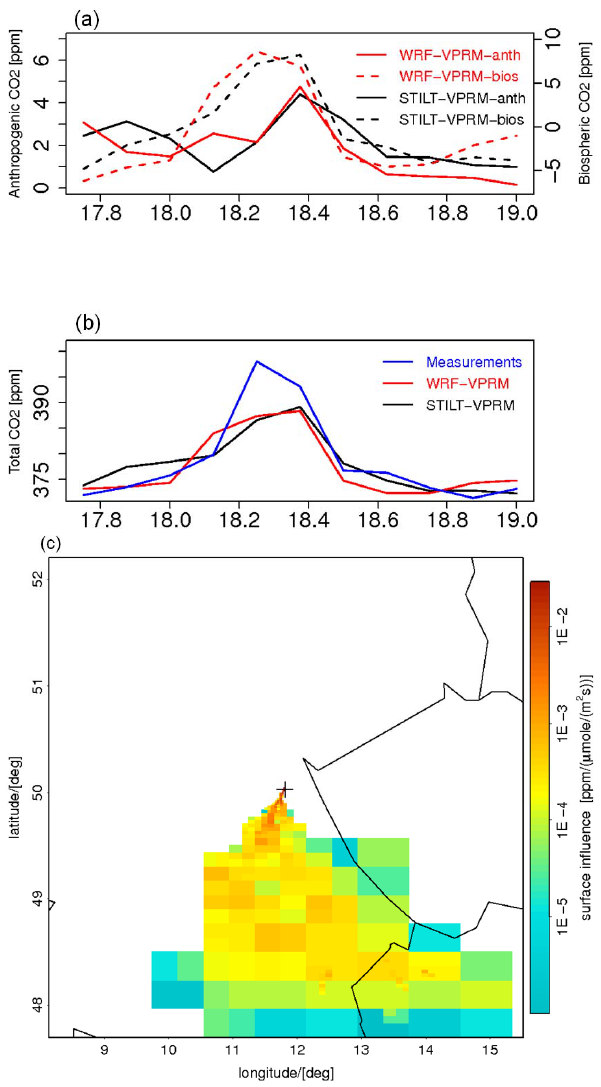
Figure 8. Influence of surface fluxes on measured CO 2 concentration at OXK: a and b) Fig. 8. Influence of surface fluxes on measured CO 2 concentra- Time series of simulated anthropogenic and biospheric CO 2 signals (contribution of tion at OXK: (a) and (b) Time series of simulated anthropogenic anthropogenic and biospheric fluxes to the total CO 2 ) at 90 m on the tower during 17-18 and biospheric CO 2 signals (contribution of anthropogenic and bio- August 2006. c) Time integrated footprints derived by STILT on 18 th August 2006 at spheric fluxes to the total CO 2 ) at 90m on the tower during 17– 7:00 UTC for particles running -48 hours (backward in time) from tower (indicated with 18 August 2006. (c) Time integrated footprints derived by STILT + sign) on 18 August 2006 at 07:00UTC for particles running − 48h (back- ward in time) from tower (indicated